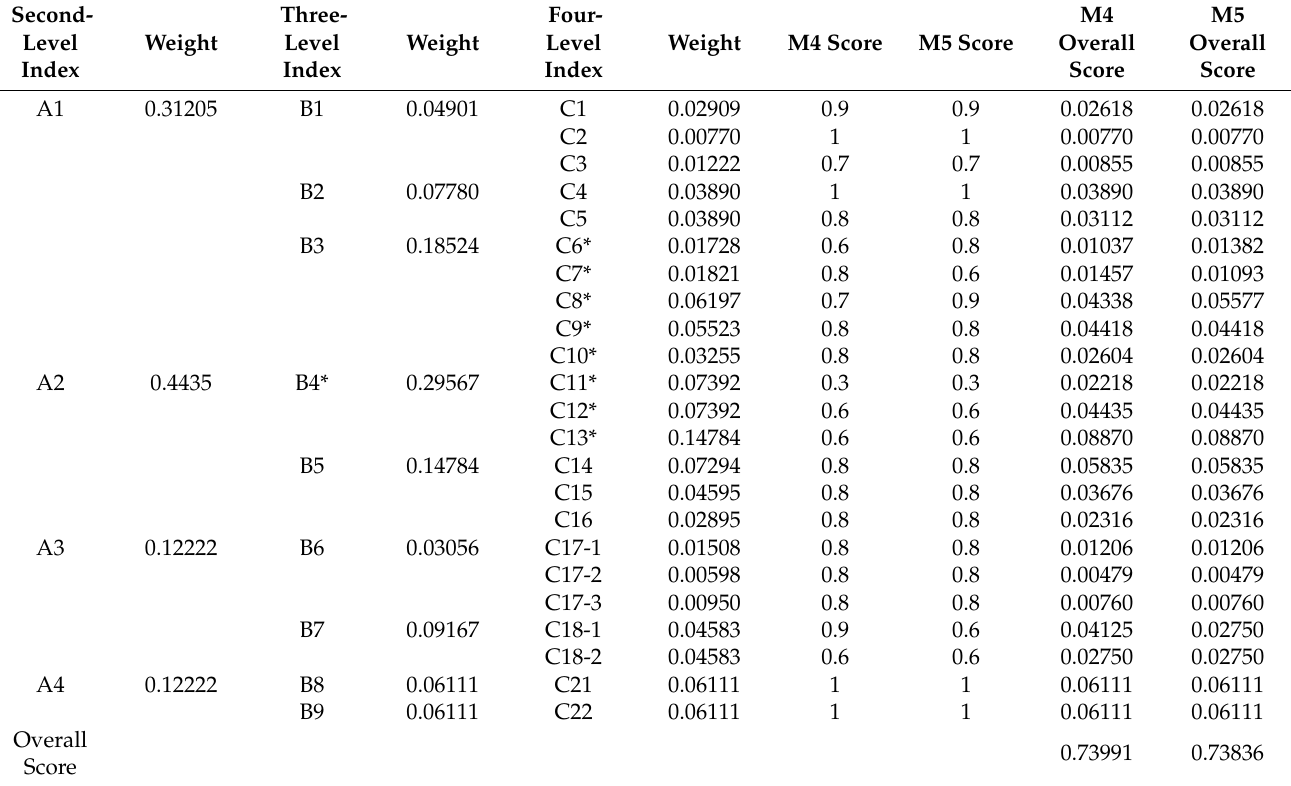
Table 6. Results of the comprehensive evaluation grade in the Jinan zhangqiu